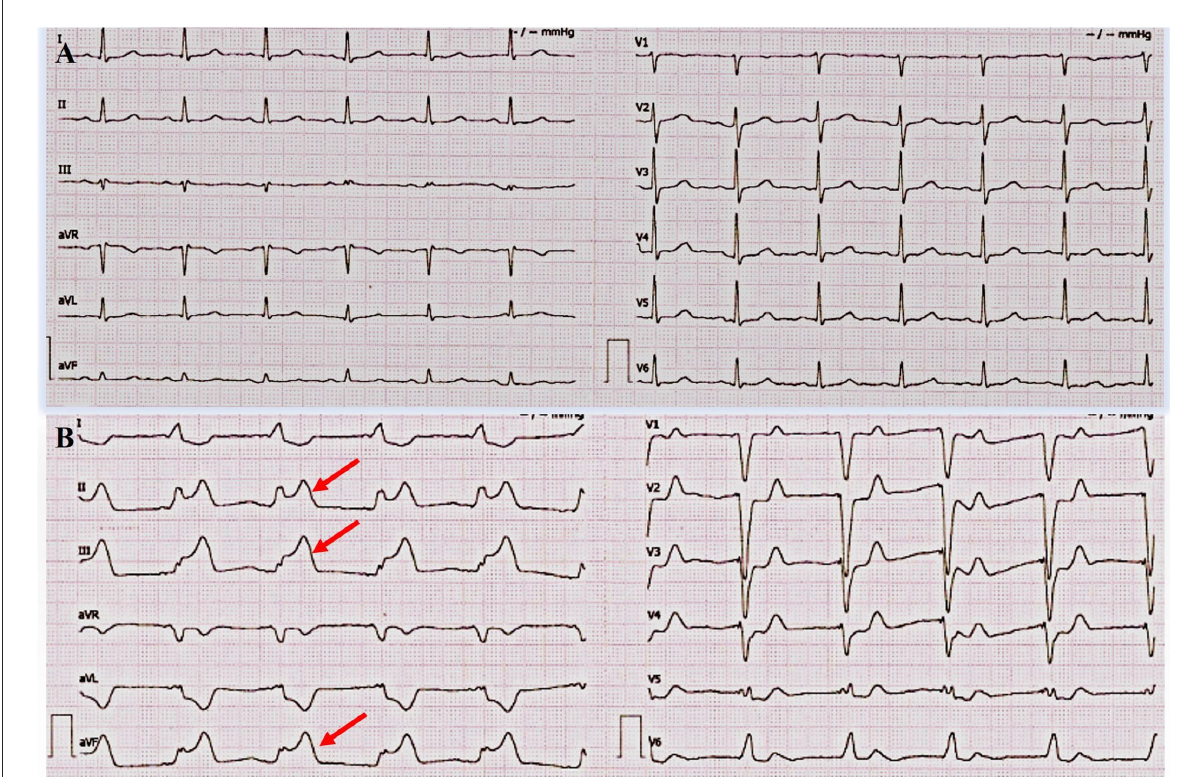
FIGURE1 Admission electrocardiogram (ECG) and acute myocardial infarction (AMI) ECG. (A) ECG on admission. It showed a sinus rhythm at 76 bpm (beats per minute), normal conduction, and low amplitude of T wave in multiple leads. (B) ECG during AMI. It showed ST segment elevation in leads II, III, and aVF and ST segment depression in leads I, aVL, and